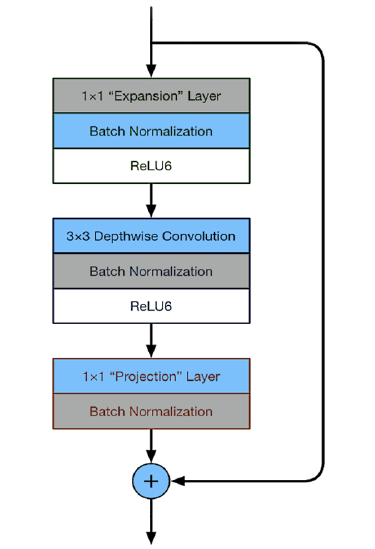
Figure 4. Bottleneck residual